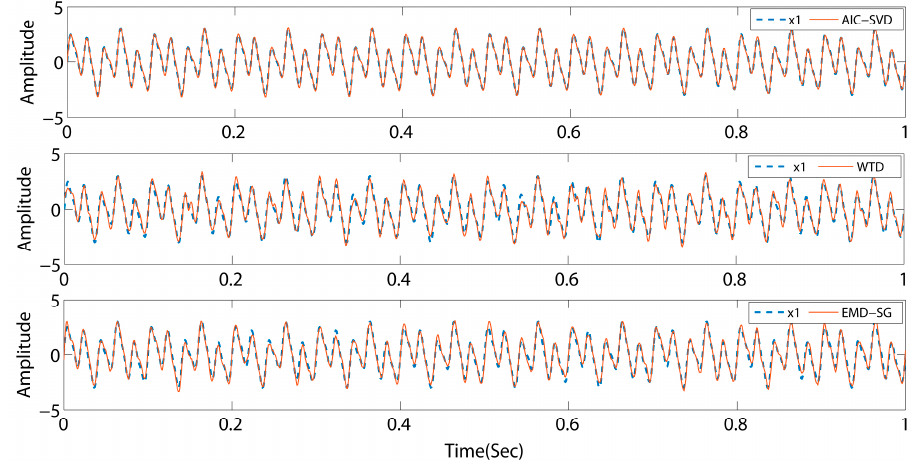
Figure 5. Comparison of denoising e ff ects by di ff erent methods for signal s 1 . WTD: wavelet threshold denoising; EMD-SG: empirical mode decomposition with Savitzky–Golay filter.